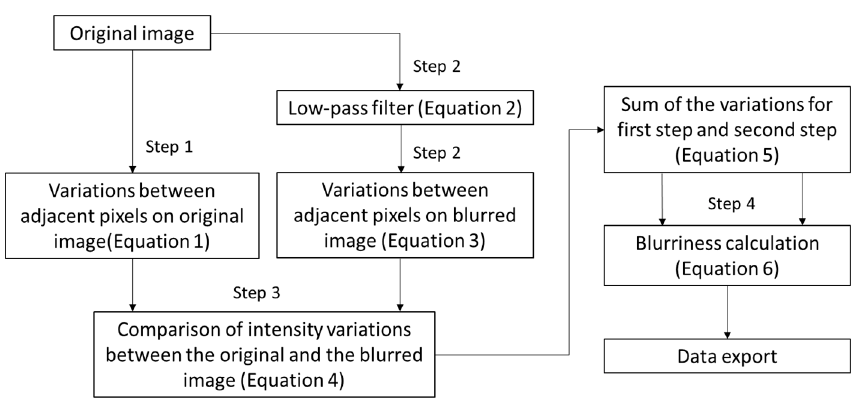
Figure 10. Blurred images captured on ( a ) June 16 and ( b ) July 25.